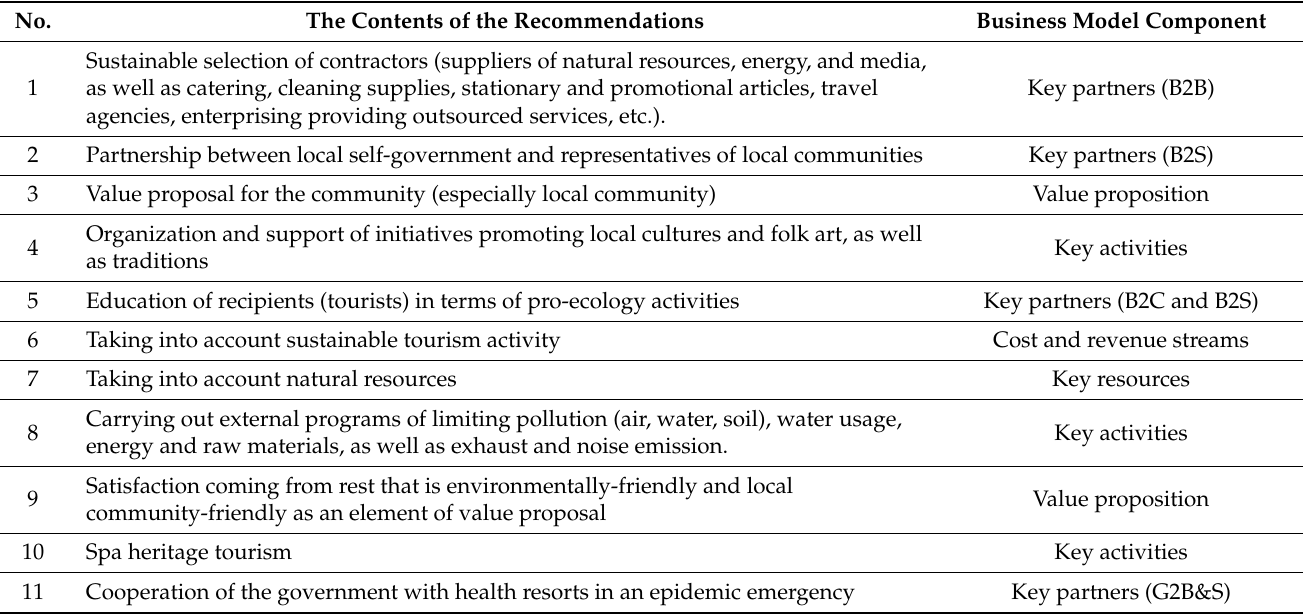
Table 3. Proposed business model components in tourist